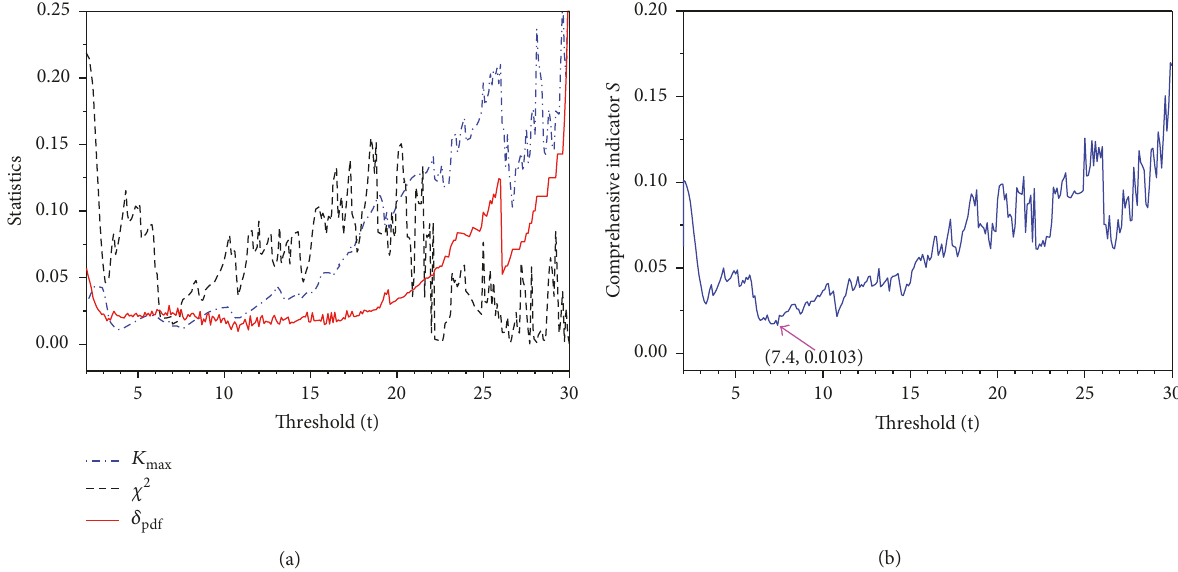
Figure 7: Goodness-of-fit test: (a) single criterion and (b) multiple criteria.